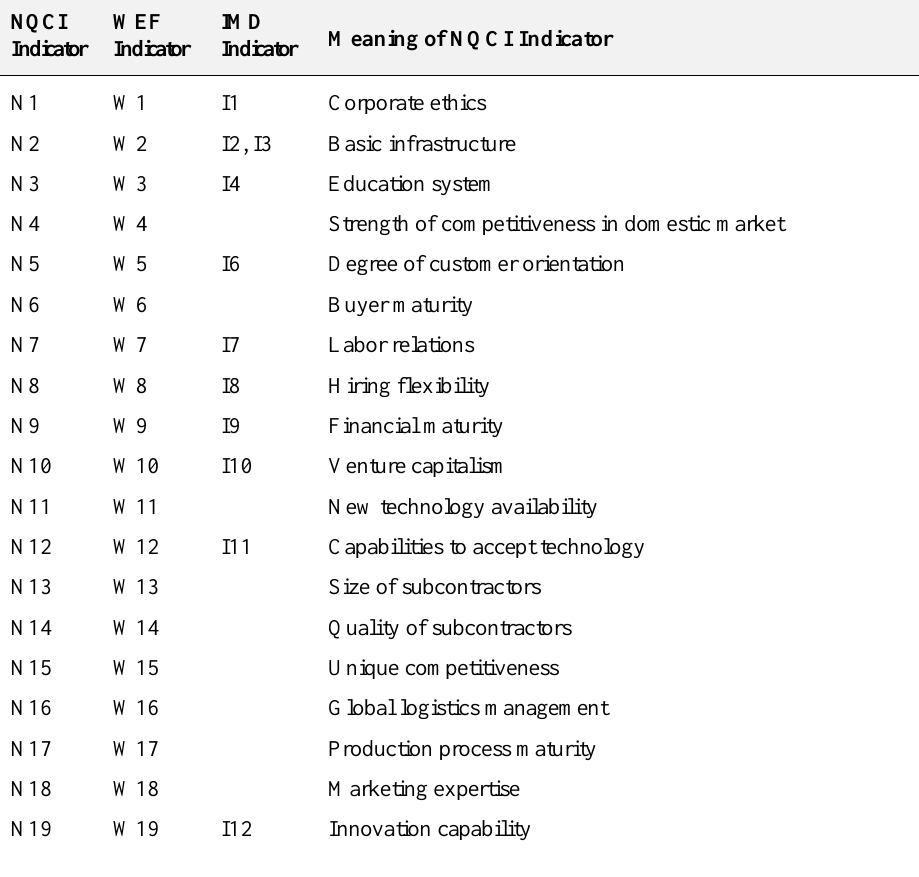
Table 5 – Creating NQCI Indicators Using WEF and IMD